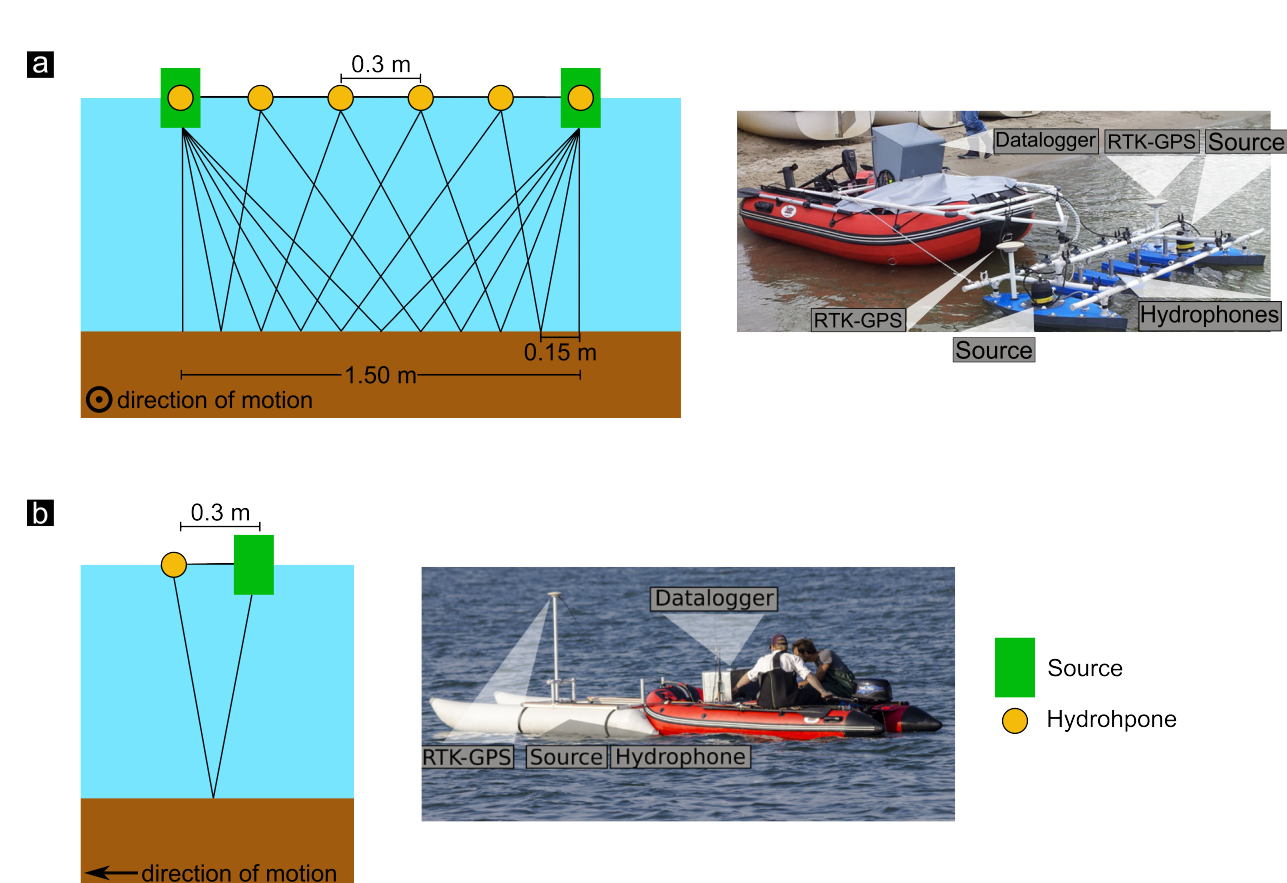
Figure 1. Schematic drawings ( left ) and photographs ( right ) of the measuring system setup for ( a ) PingPong configuration and for ( b ) constant-offset configuration. The direction of motion in the drawings equals that in the photographs and is indicated by an arrow and circle for the direction out of the image plane. Adapted from